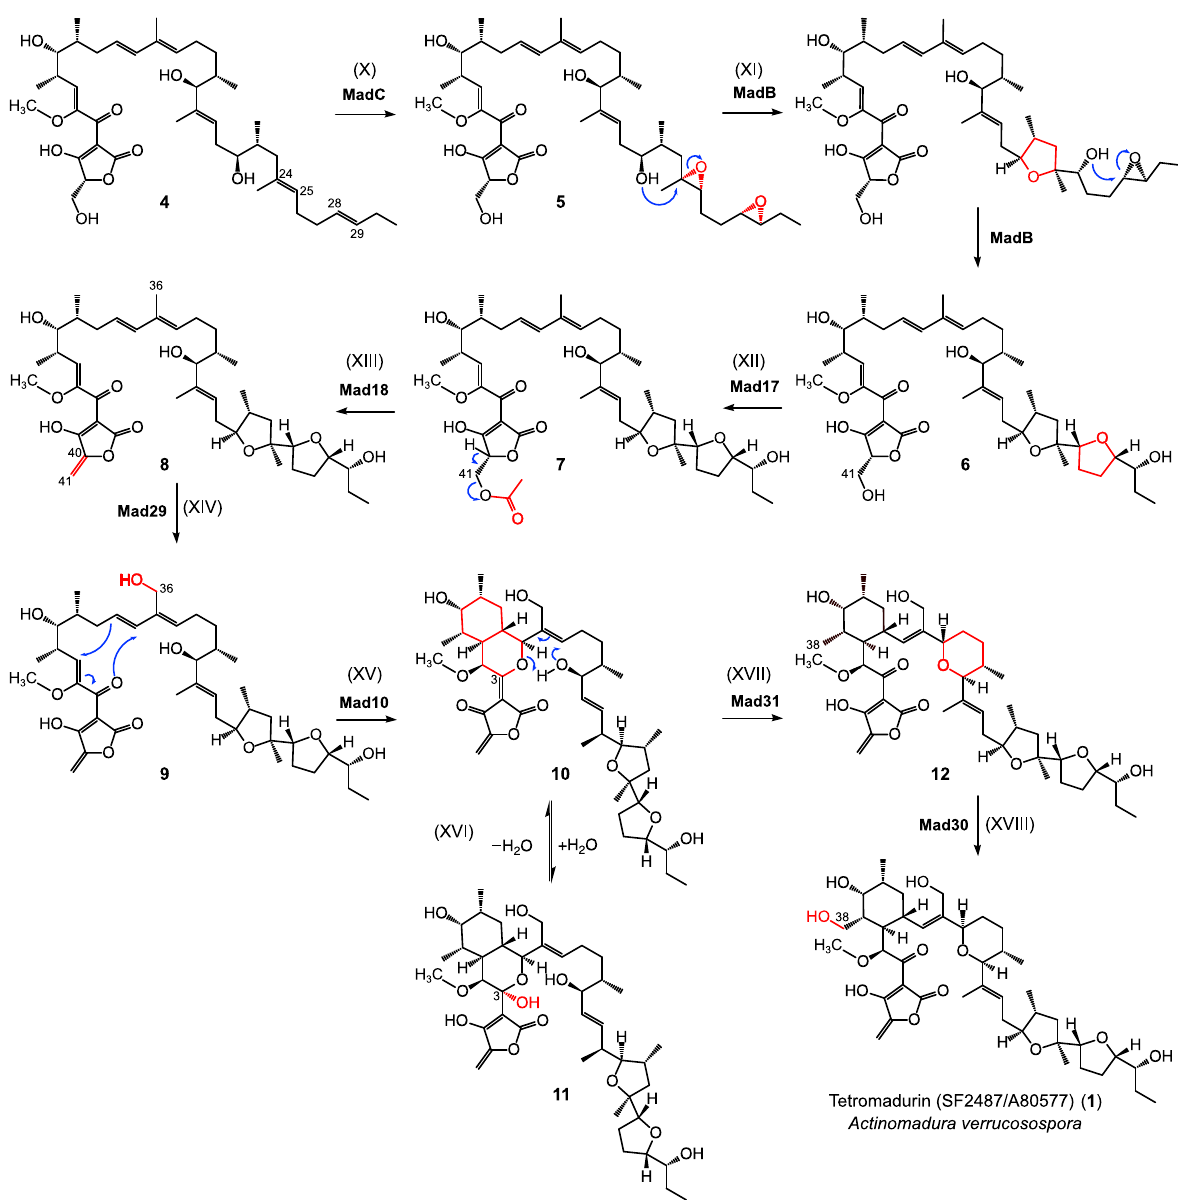
Fig 5. The proposed biosynthetic pathway of tetromadurin (part 2). (X) In the first step of tetrahydrofuran formation, MadC catalyses epoxidation of the C24-C25 and C28-C29 E double bonds. (XI) The epoxide hydrolase MadB catalyses formation of the two tetrahydrofuran rings through a cascade epoxide ring-opening; (XII) Acetylation of the C41 hydroxyl group is catalysed by Mad17. (XIII) Elimination of the acetyl group by Mad18 forms the C40-C41 exocyclic double bond. (XIV) Hydroxylation of C36 by Mad29. It is possible this hydroxylation event takes place earlier in the biosynthesis (XV) Mad10 catalyses the formation of an oxadecalin containing intermediate 10 . (XVI) The equivalent oxadecalin intermediate in tetronasin biosynthesis acquired a water at C3 to form a hemiacetal [7]. Given the structural similarity between tetromadurin and tetronasin, it is likely the tetromadurin oxadecalin intermediate can be hydrated at C3 to form 11 . (XVII) Mad31 catalyses formation of the tetrahydropyran ring and dismantles the oxadecalin ring to form 12 . (XVIII) Mad30 then catalyses hydroxylation of C38, forming tetromadurin 1 . Bonds/atoms have been coloured red to highlight the chemical